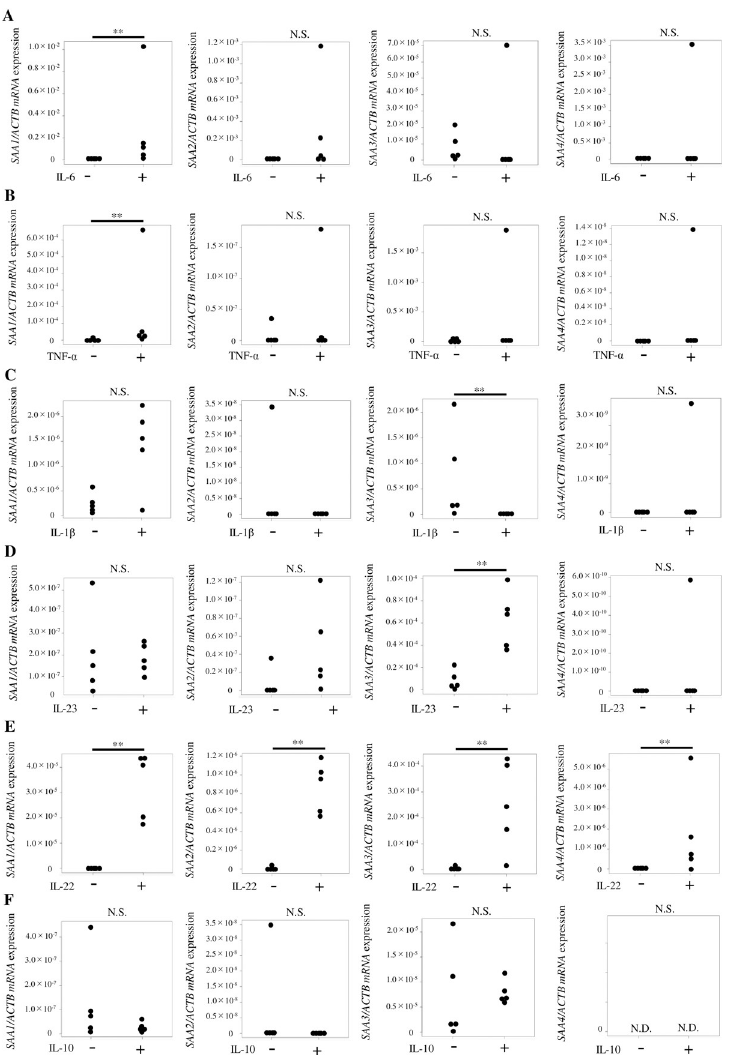
Fig 2. SAA1-4 expression in mouse small intestinal organoids upon stimulation with several cytokines. Normalized SAA expression levels in small intestinal organoids upon stimulation with (A) IL-6 (10 ng/mL), (B) TNF- α (10 ng/mL), (C) IL-1 β (100 ng/mL), (D) IL-23 (50 ng/mL), (E) IL-22 (50 ng/mL), or (F) IL-10 (50 ng/mL) for 24 h. Only IL-6, TNF- α , and IL-22 promoted a significant increase in SAA1 expression level when compared with untreated controls. Although not statistically significant, the expression level of SAA1 tended to increase upon IL-1 β stimulation and was suppressed by stimulation with IL-10. It was difficult to evaluate SAA2 and SAA4 expression because their expression levels were not detectable (A-F). The expression level of SAA3 was significantly increased by IL-22 and IL- 23 (D, E). However, unexpectedly, SAA3 was downregulated by IL-1 β (C). SAA expression level was normalized to that of ACTB and is represented as the mean ± standard deviation (n = 5). �� P < 0.01 versus untreated controls. N.S., not significant; N.D., not